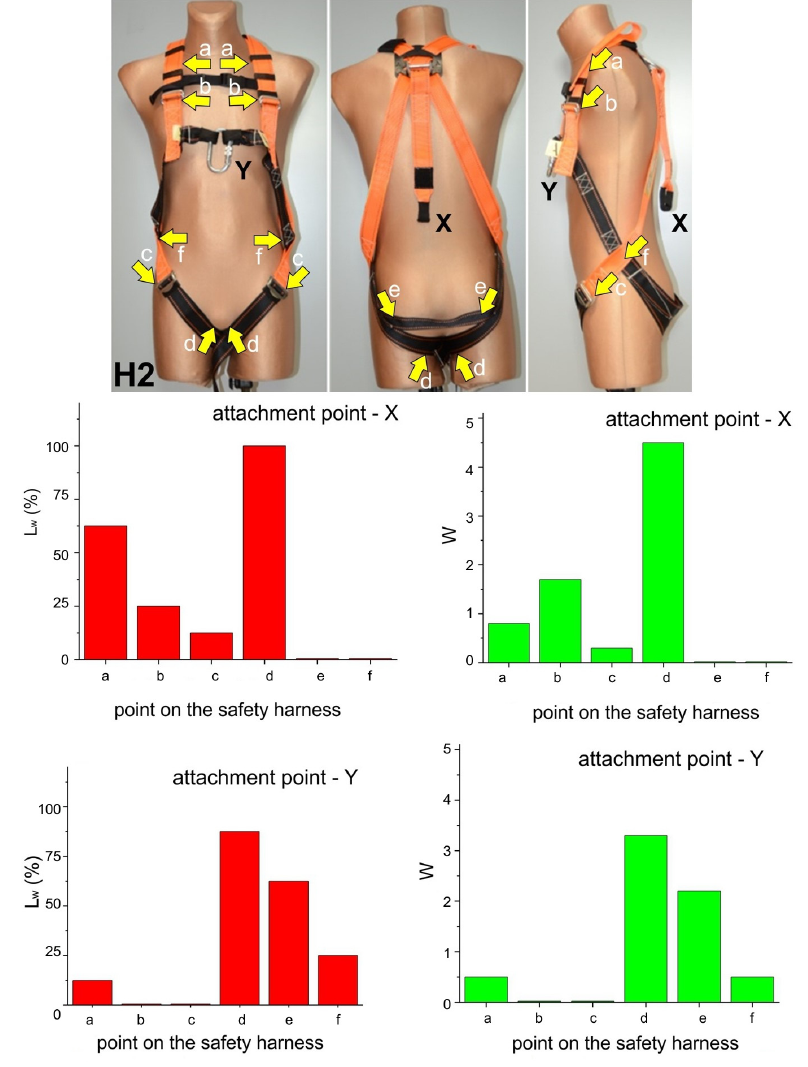
Figure 4. Test results for harness H2.